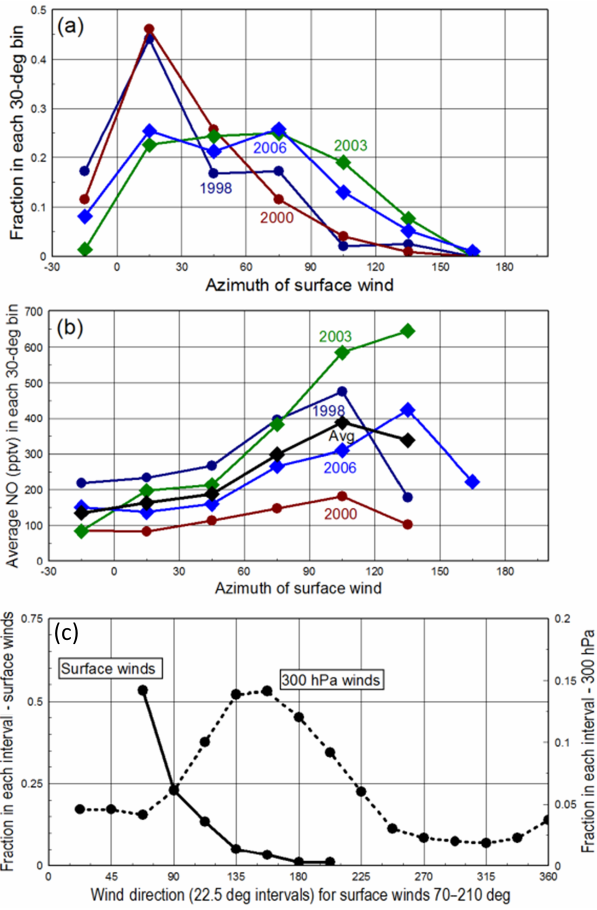
Figure 4. (a) Comparison of surface wind direction distributions for 1998, 2000, 2003, and 2006, (b) the average NO over each year as a function of wind azimuth in 30 ◦ bins. Wind directions between 210 ◦ and 340 ◦ ( − 20 ◦ ) are not included because of poten- tial contamination from the station and aircraft operations. A total of 3300hourly values of NO were averaged in 30 ◦ wind-direction bins. (c) Distribution of 300hPa wind directions when the surface wind is between 60 ◦ and 180 ◦ and greater than 1ms − 1 . Also shown is the distribution of surface winds when the 300hPa wind direc- tions are between 120 and 150 ◦ . Median values are 100 and 134 ◦ , respectively, showing that surface winds are more easterly when winds aloft are from the